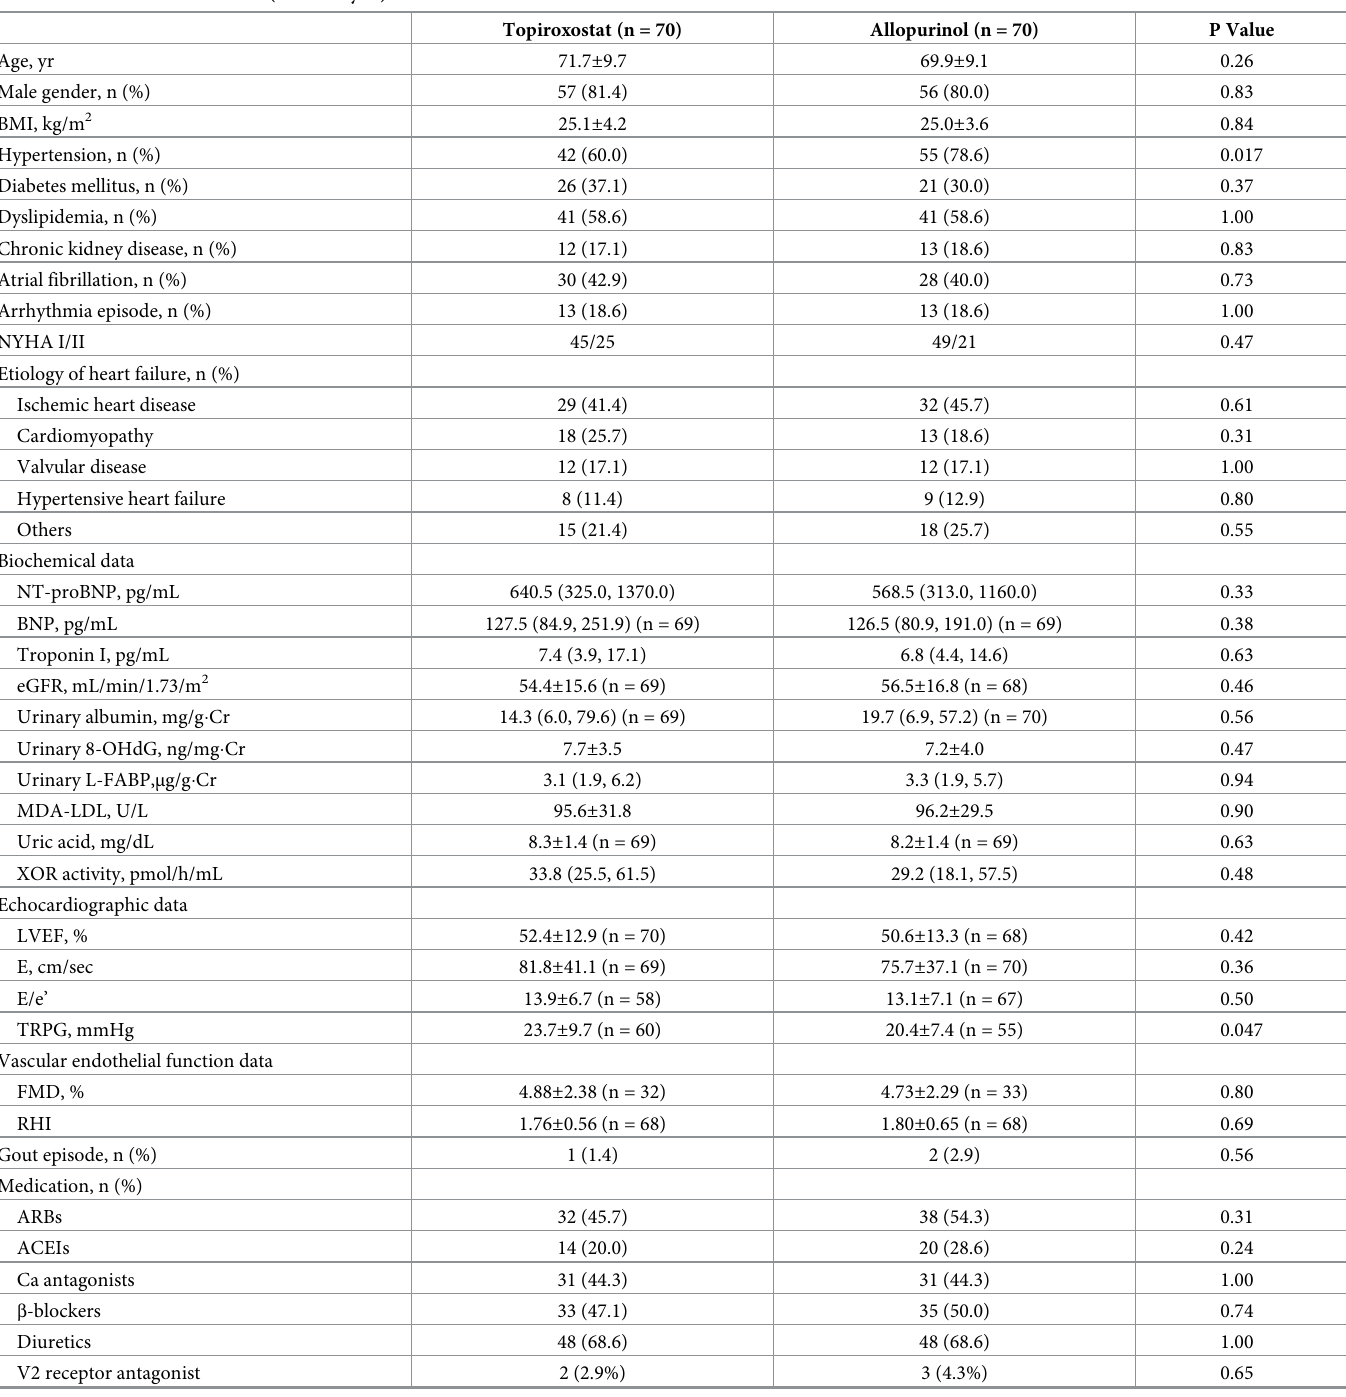
Table 1. Baseline characteristics (FAS